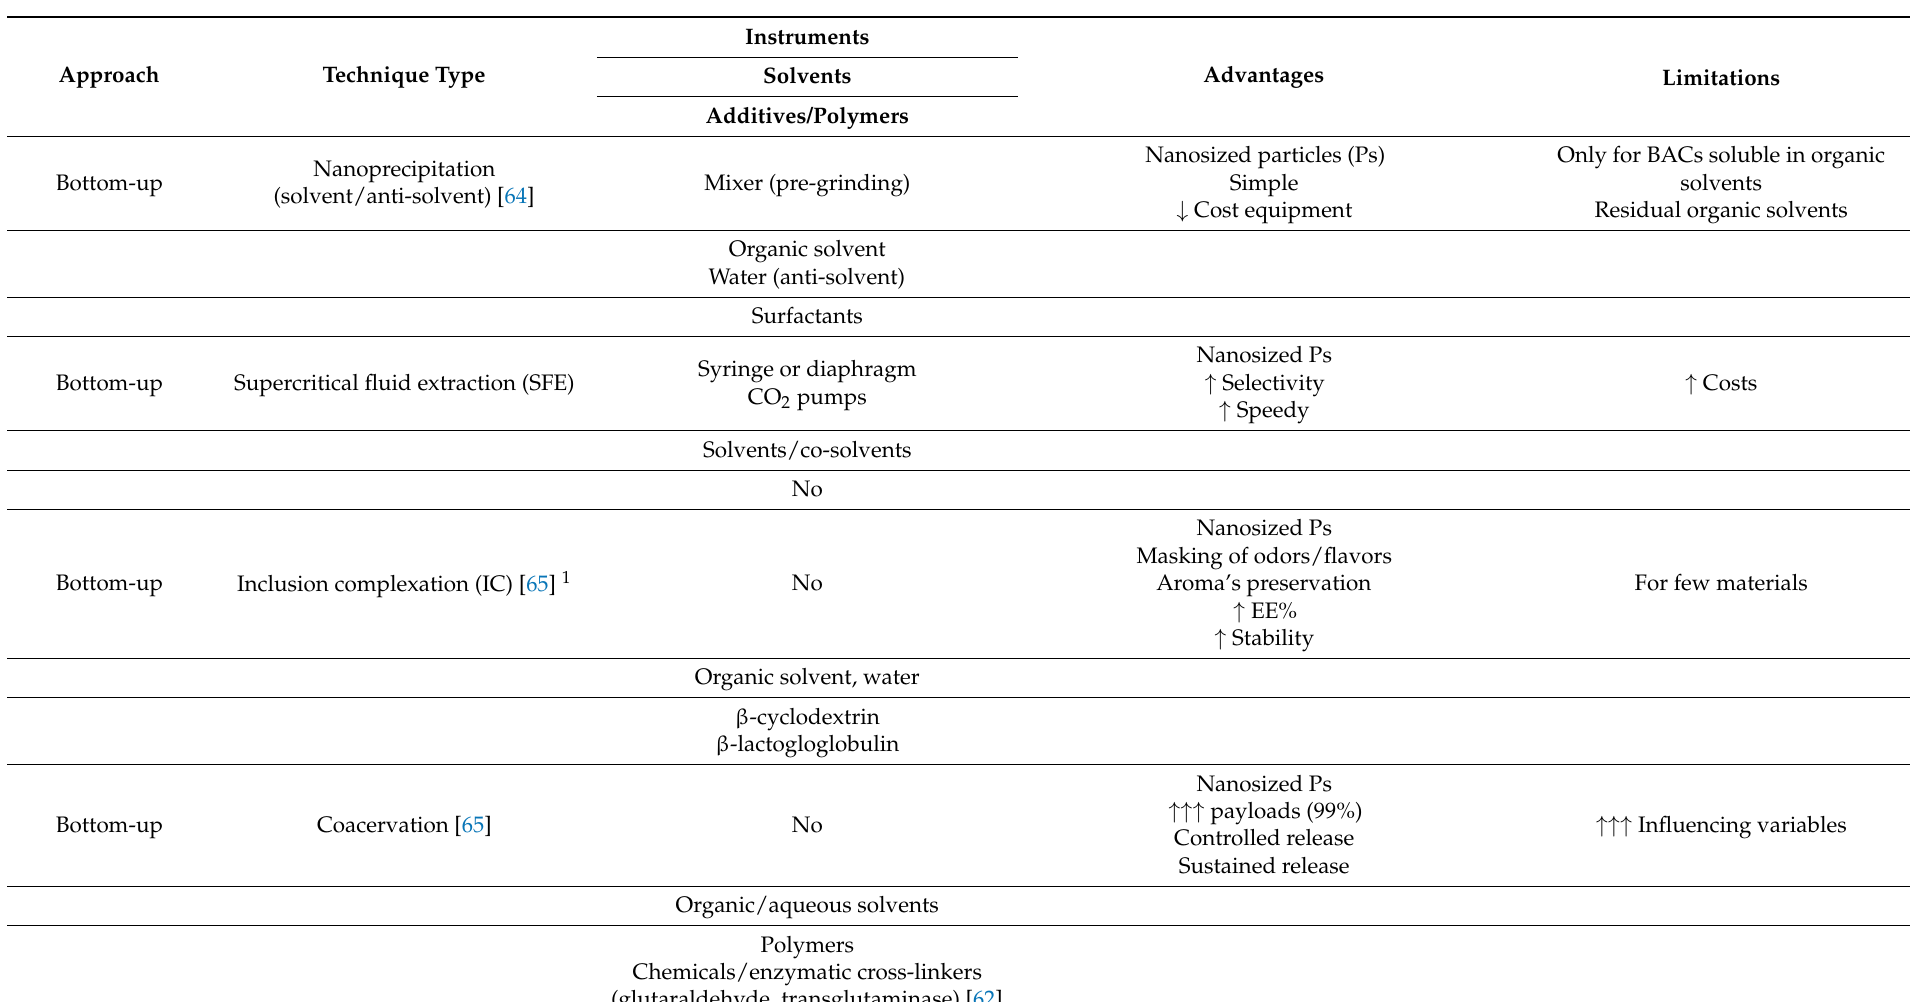
Table 4. Details concerning the most used top-down and bottom-up methods to prepare